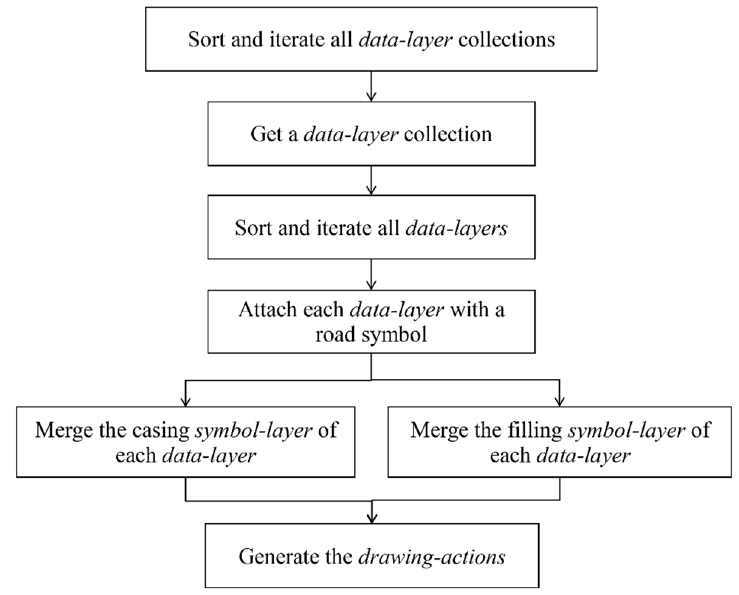
Figure 9. Basic process to generate the drawing-actions.